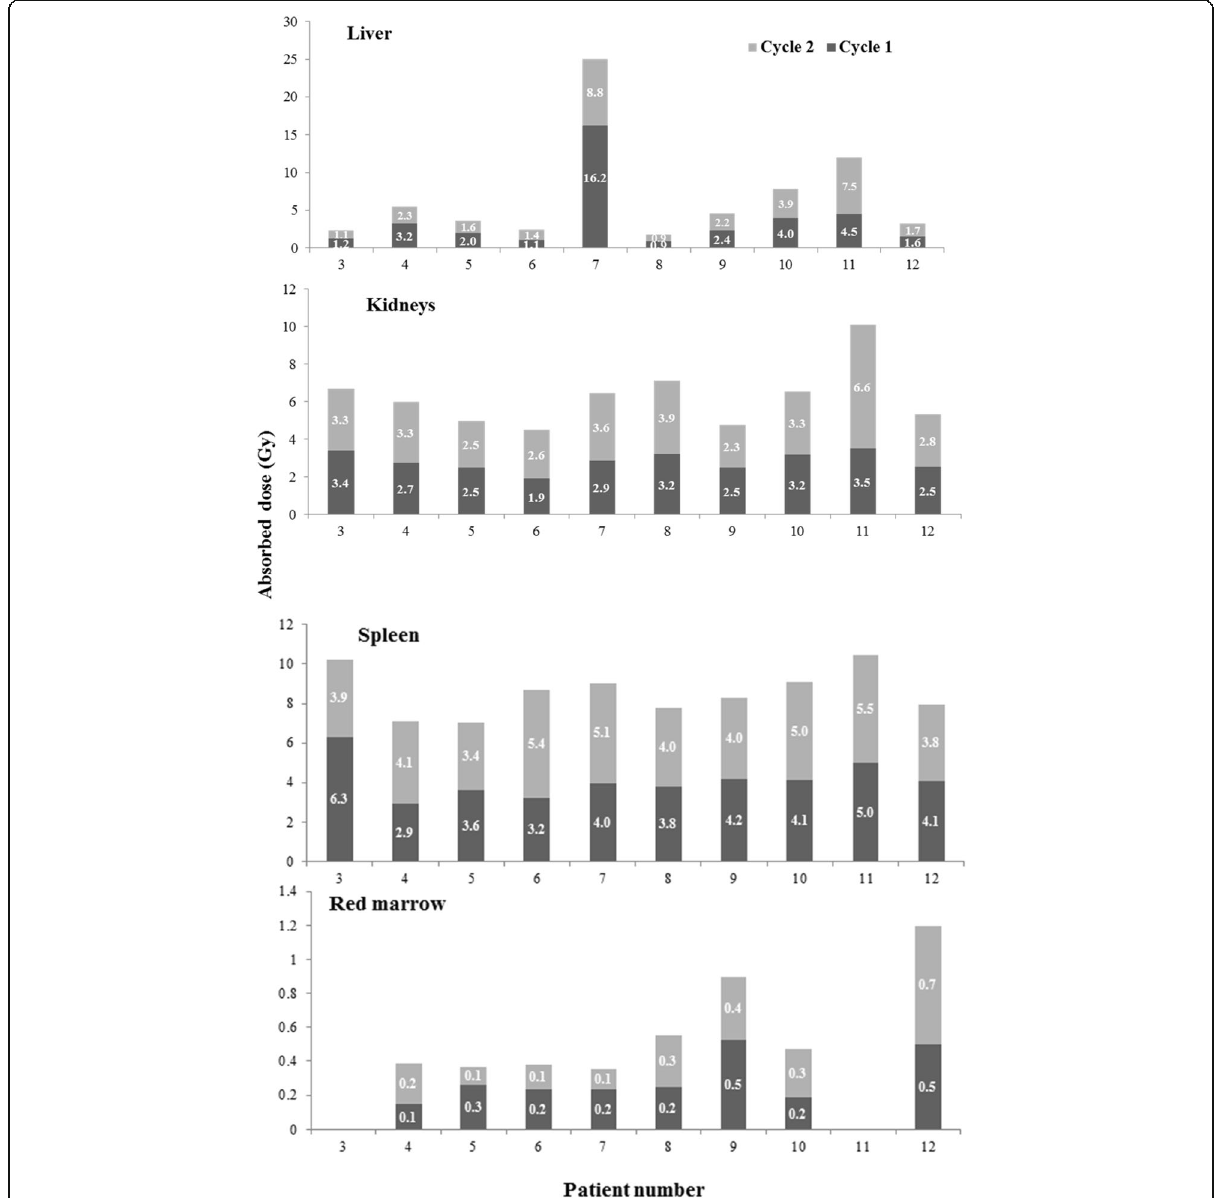
Fig. 5 Absorbed doses in Gy in liver, kidneys, spleen, and red marrow after cycle 1 and after cycle 2. As our dosimetry methodology was based on L2-L3- L4 red marrow delineation, it could not be used for patients 3 and 11 who had tumors in contact with L2, L3, L4 and L2, L3 or L4 vertebral